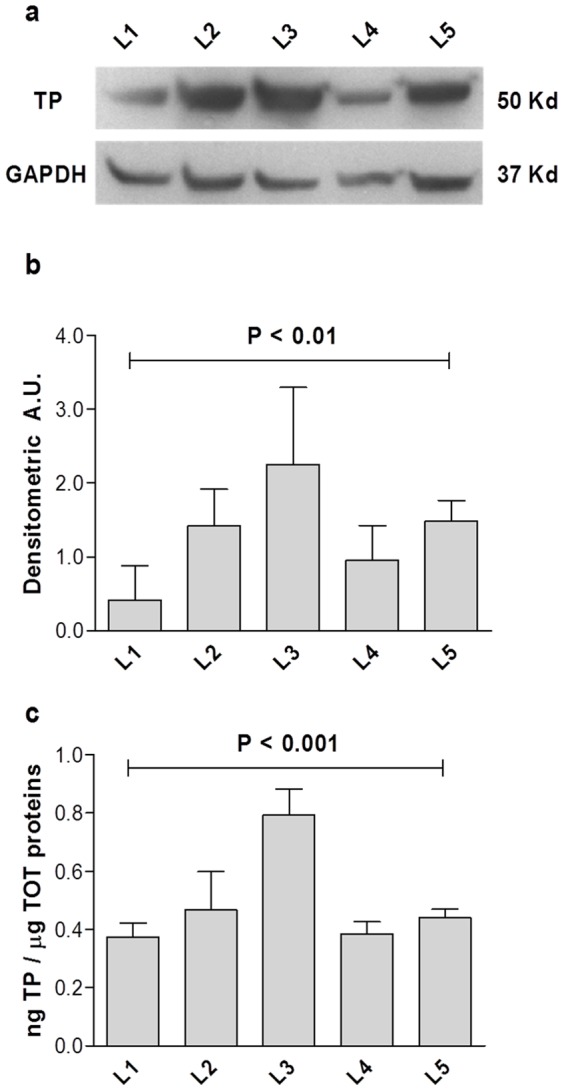
TP occurrence and concentration in control liver.
Figure 1A shows an example of a WB separation of 50 ng total protein from healthy liver. TP and reference protein GAPDH chemioluminescence are reported from liver L1 to L5. Figure 1B illustrates the densitometric arbitrary units (A.U.) calculated normalizing TP chemioluminescent signal on the internal reference protein GAPDH ± SD and showing a significant variability among non-MNGIE subjects (P< 0.01, one way non parametric test ANOVA). The graph in Figure 1C reports the TP concentration measured by ELISA and expressed as ng TP/μg total proteins for the 5 liver tissue samples ± SD and showing a significant variability among non-MNGIE subjects (P< 0.001, one way non parametric test ANOVA).